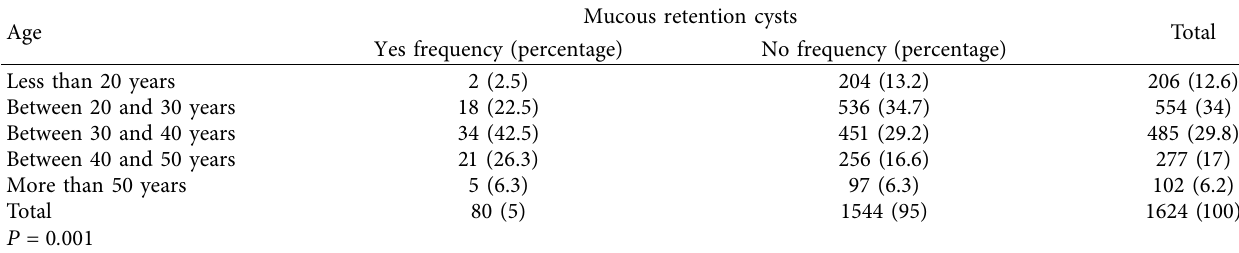
Mucous retention cysts